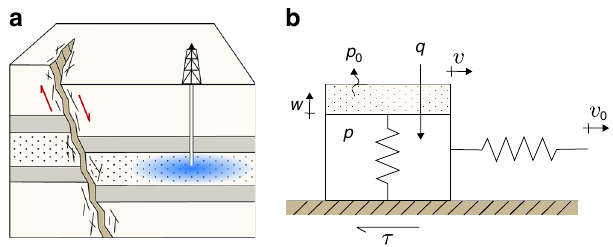
Fig. 1 Conceptual picture of induced seismicity including poroelastic effects. a Fluid injection induces effective stress changes in the reservoir surrounding the fault, increasing the likelihood of fault slip and earthquake triggering. b Our spring – poroslider model of a fault segment in contact with the reservoir. Here, v 0 is the loading velocity, v is the velocity of the block, τ is the frictional shear force, w is the elongation of the piston, q is the injection rate, p 0 is the ambient pressure, and p is the pressure inside the